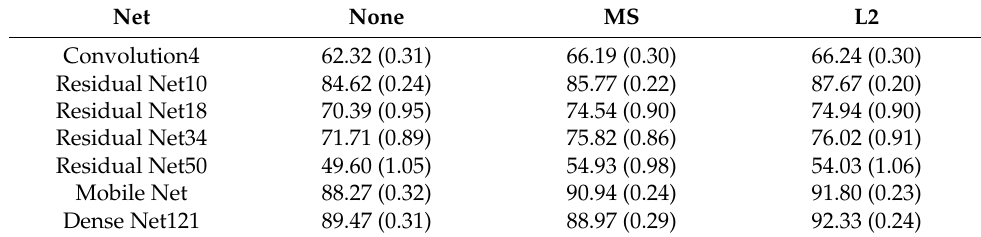
Table 3. 5-shot Setting, the average accuracy rate of different classification networks, in %.